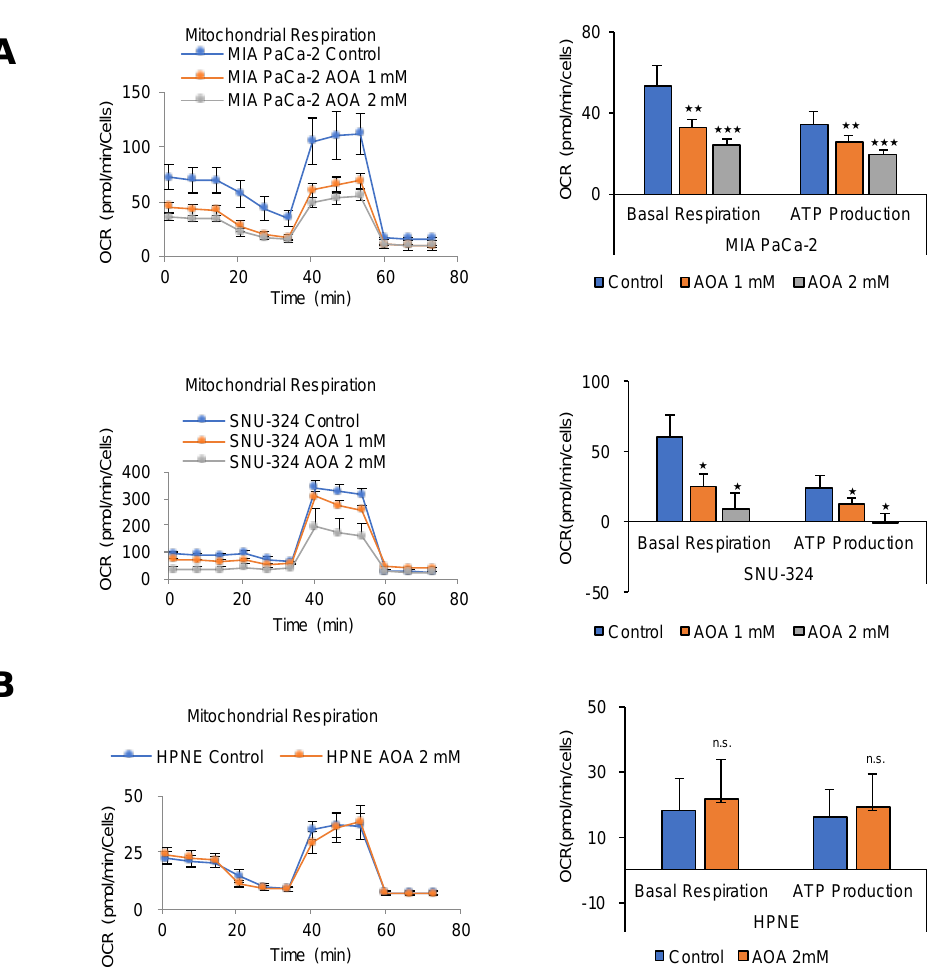
Figure 4. MAS inhibition dose-dependently decreases ATP synthesis in PDAC cells but not in normal cells. ( A ) OCR in response to 1 mM or 2 mM of AOA was analyzed using the Seahorse XFe96 analyzer in MIA PaCa-2, SNU-324, and ( B ) HPNE cells. Abbreviations: AOA, amino-oxy acetate. n.s. (not significant), * p < 0.05, ** p < 0.01, *** p < 0.001 compared with the vehicle control.